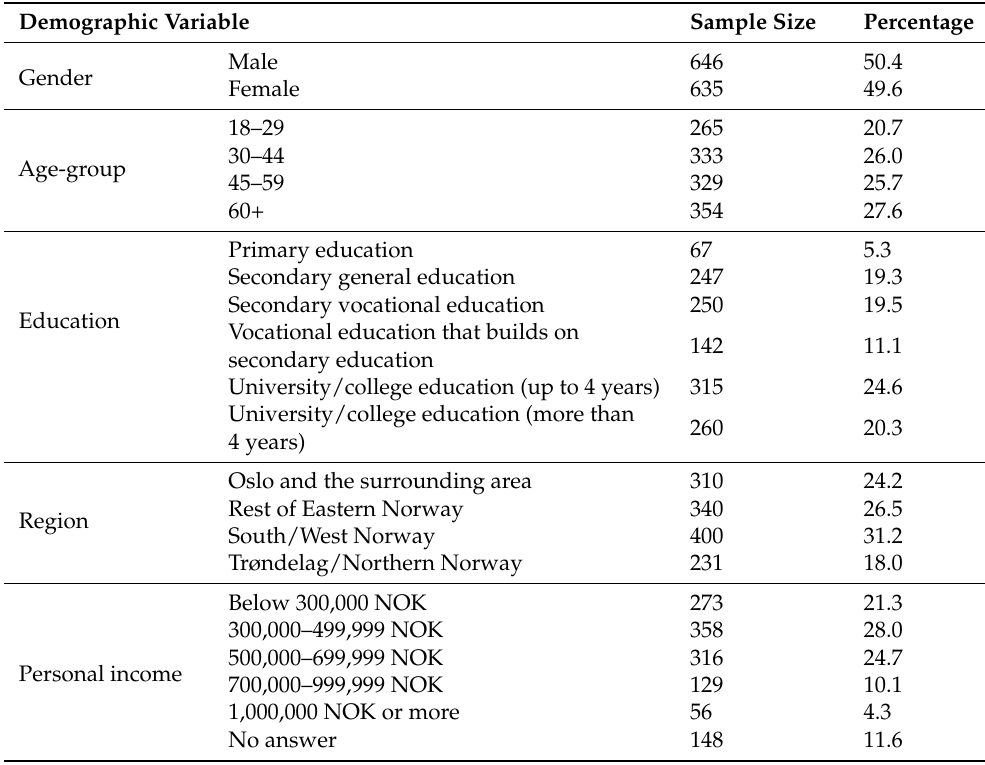
Table 1. The demographic characteristics of the respondents (weighted data, N =